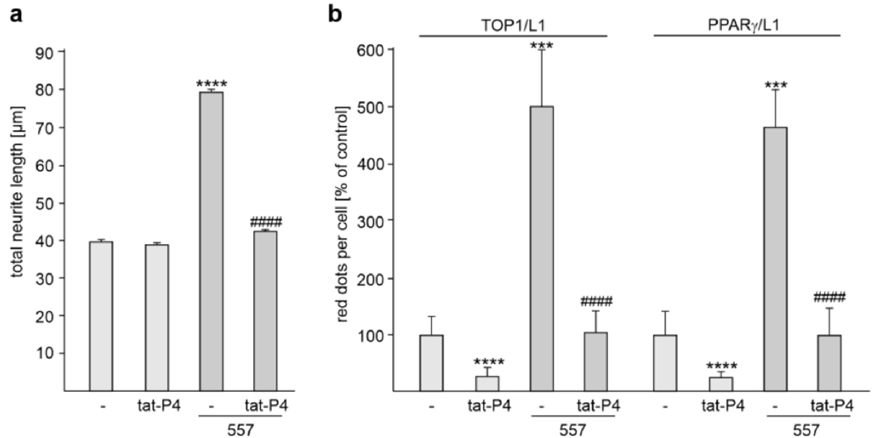
peptide P4 (see, Figure 3c), we treated cortical neurons with or without the L1 antibody whether the interaction of L1 with TOP1 and PPAR γ is required for L1-dependent neurite outgrowth in vitro. Treatment with the peptide in the absence of L1 antibody 557 had no effect on neurite outgrowth when compared with untreated neurons (Figure 7a). In the absence of tat-P4 peptide, L1 antibody 557 enhanced neurite outgrowth, while no L1 antibody-enhanced neurite outgrowth was observed in the presence of the peptide (Figure 7a). The results indicate that L1-dependent neurite outgrowth depends on the interaction of L1 with TOP1 and PPAR γ and that the disturbance of these interactions reduces L1-stimulated neurite outgrowth.